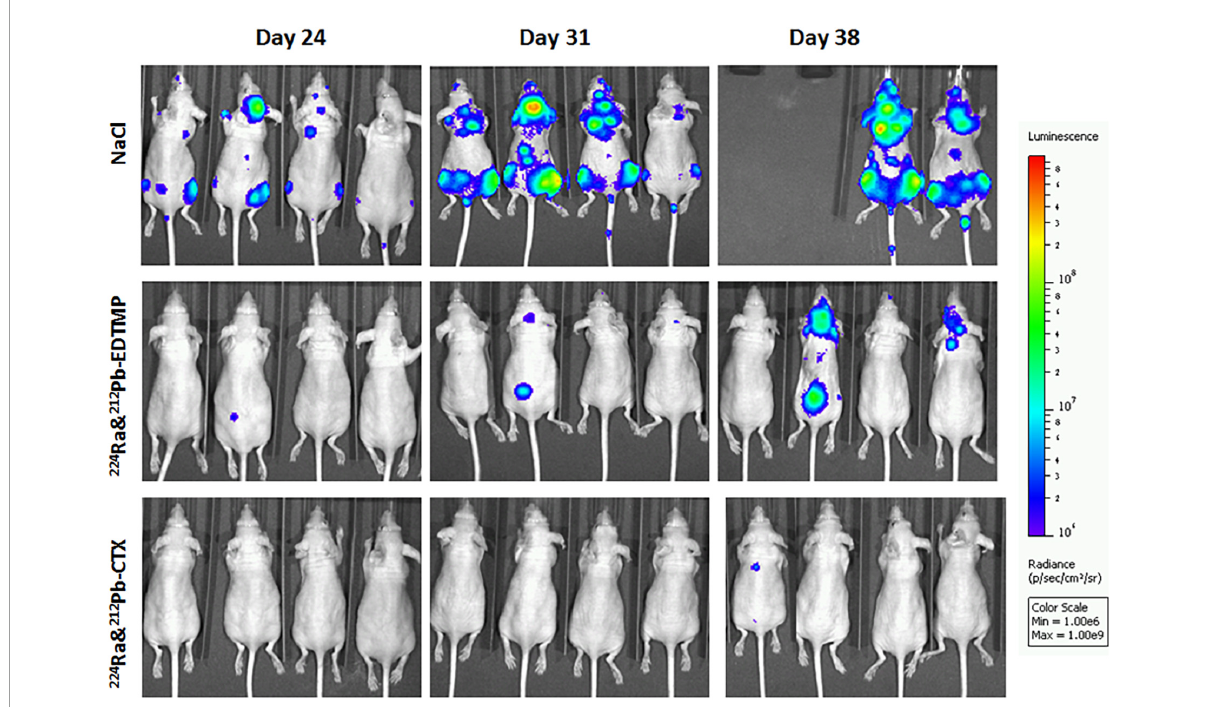
FIGURE3 The influence of dual targeting alpha solution on breast cancer metastases growth in mice. Tumor metastases were monitored by bioluminescence imaging in the different therapy groups 24, 31, and 38 days after intravenous injection of 0.9% sodium chloride (NaCl,